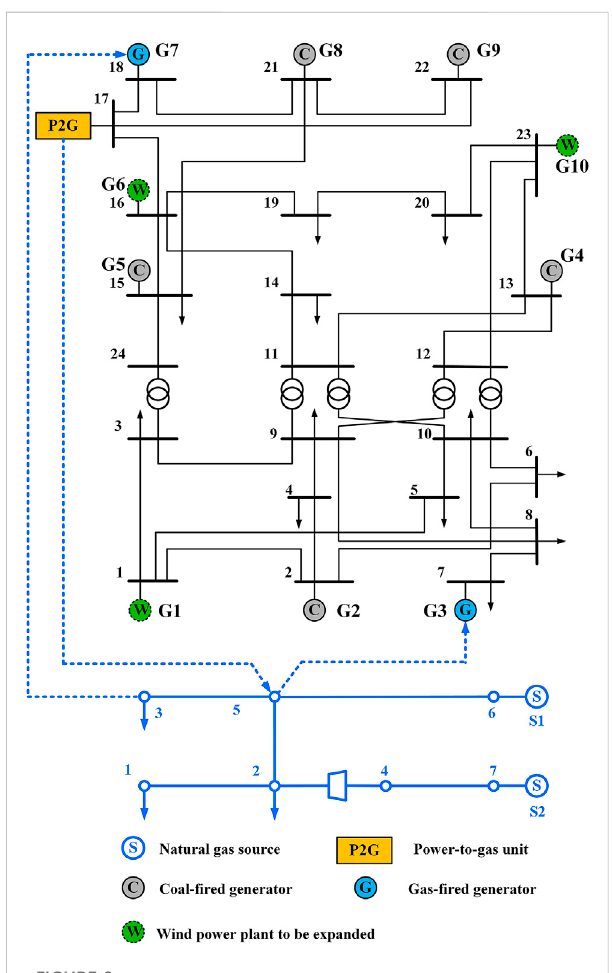
FIGURE 2 Integrated energy system coupled with IEEE 24-bus power system and 7-node natural gas